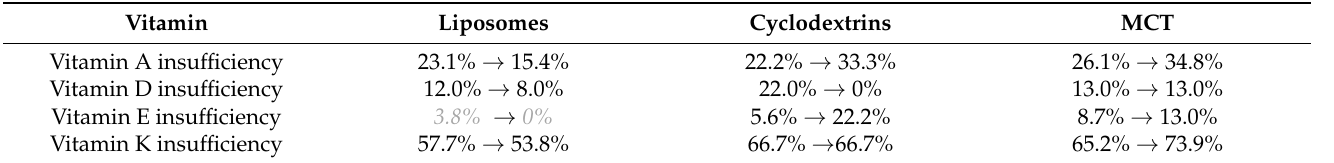
Table 6. The secondary outcome. Changes in the frequency of vitamin A, D, E, and K insufficiencies in PI CF patients during three-month supplementation of fat-soluble vitamins in liposomes, cyclodextrins, and MCT. In the liposomal group, standard vitamin E preparation was used for technical reasons. Frequencies at the start and end of the intervention are provided. None of the differences were statistically significant (Fisher’s exact test). Studied doses of vitamin A and E were lower than that typically used by the patients before